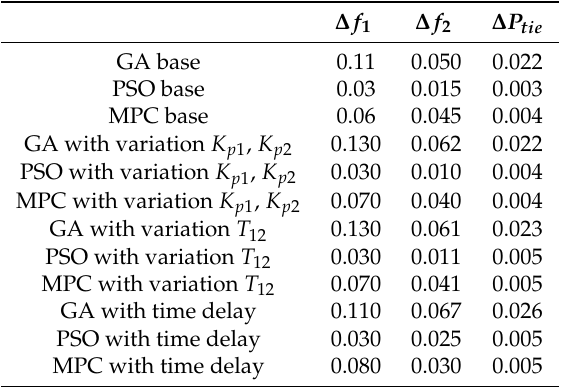
Table 4. Dynamic response comparison in terms of peak